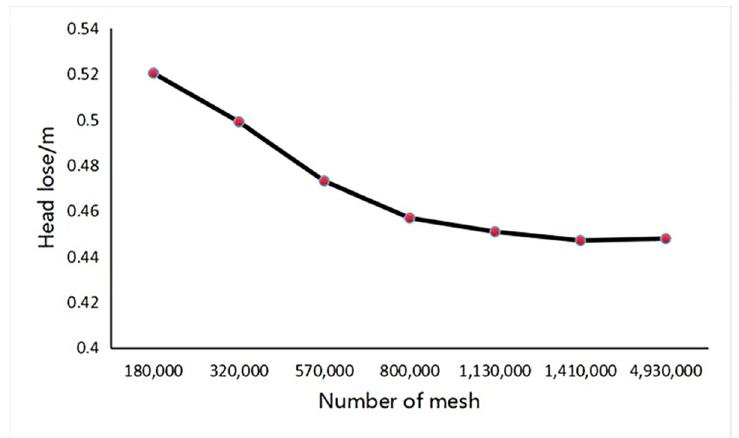
Figure 3. Head loss at different numbers of mesh.